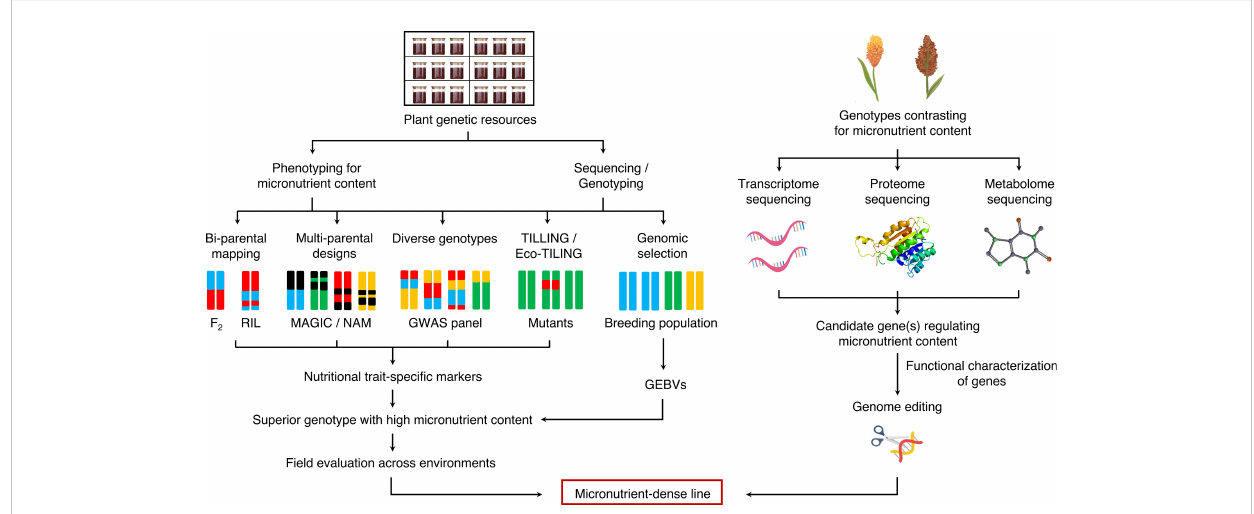
FIGURE 2 Genomic breeding strategies for enhancing nutritional content in millets. RIL, recombinant inbred line; MAGIC, multi-parent advanced generation inter-cross; NAM, nested association mapping; GWAS, genome-wide association study; TILLING, targeting induced local lesions in genomes; GEBV, genomic estimated breeding